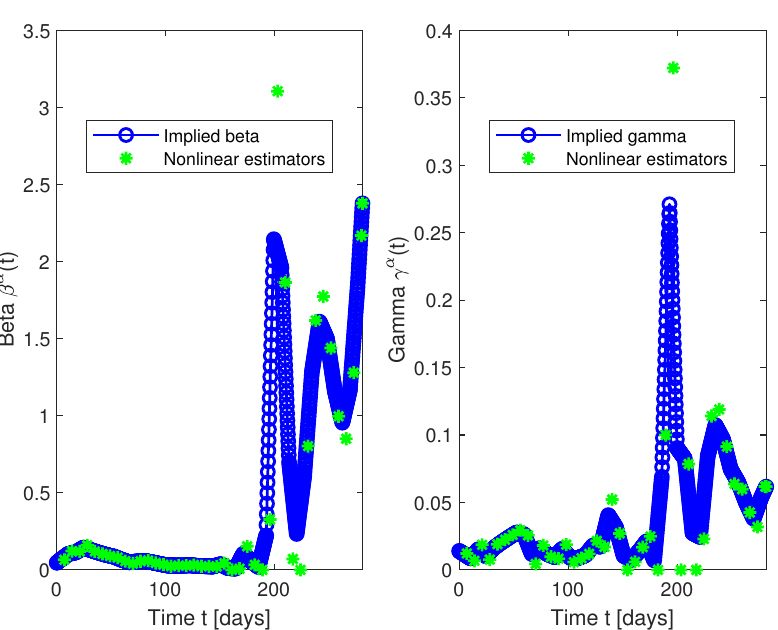
Figure 8. Recovered parameters β ( t ) and γ ( t ) for α =